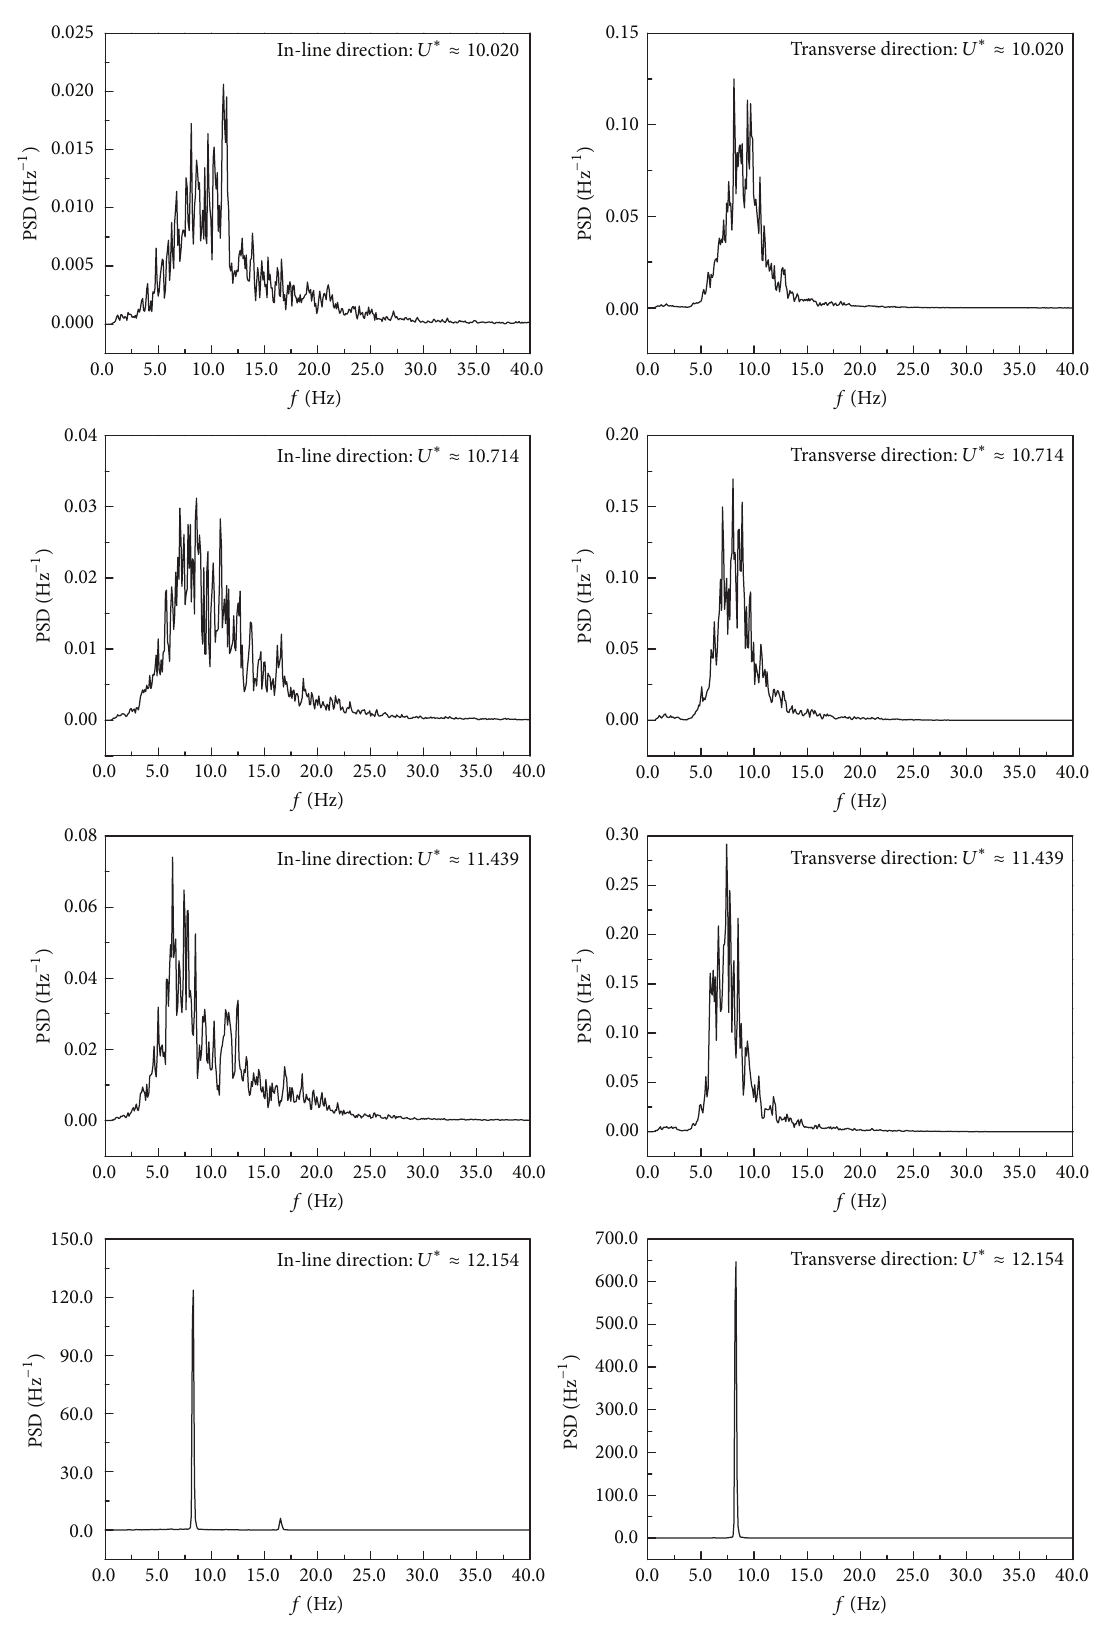
Figure 10: Power spectrum density functions of stainless steel tube vibrations with the increasing of flow